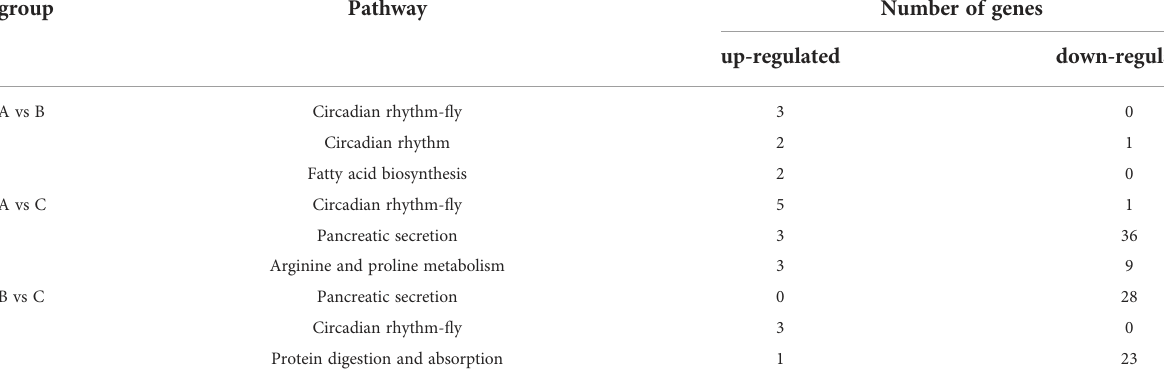
TABLE 3 The number of up-regulated and down-regulated genes in the top three signi fi cantly enriched pathways.